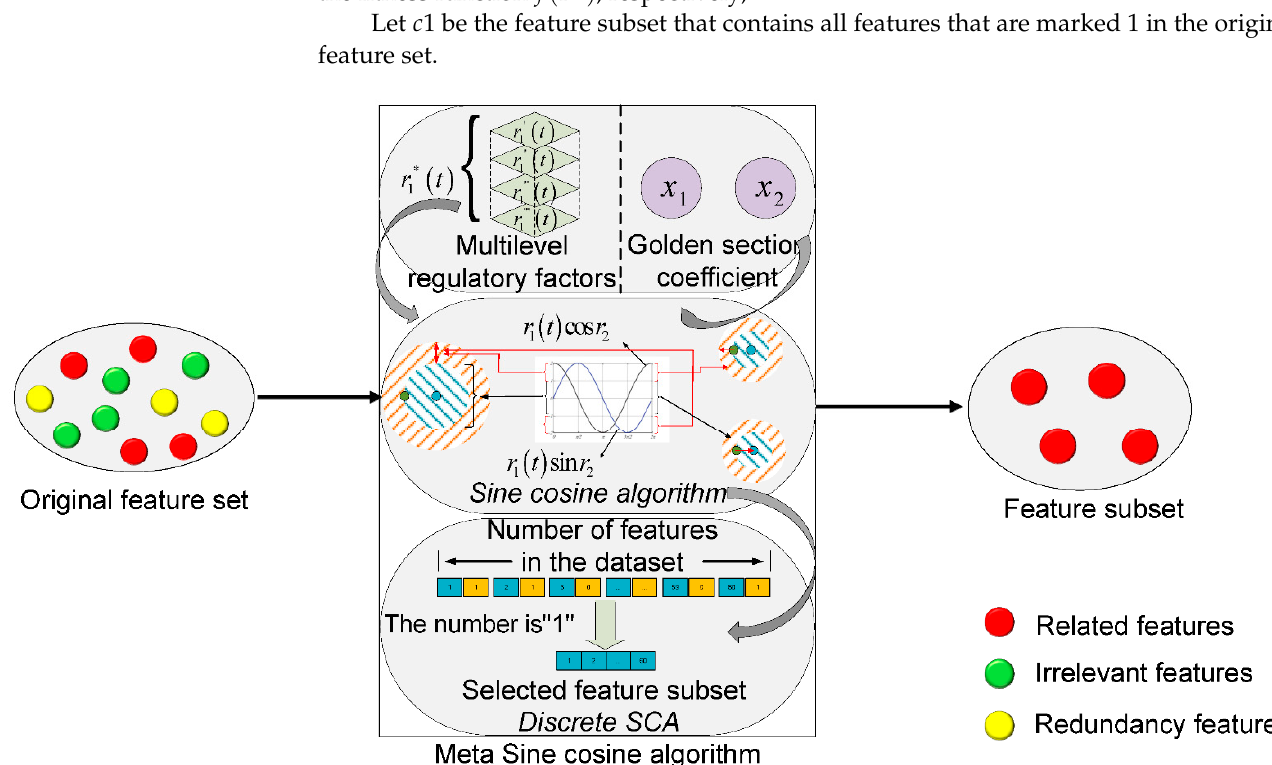
Figure 1. MetaSCA for feature selection.